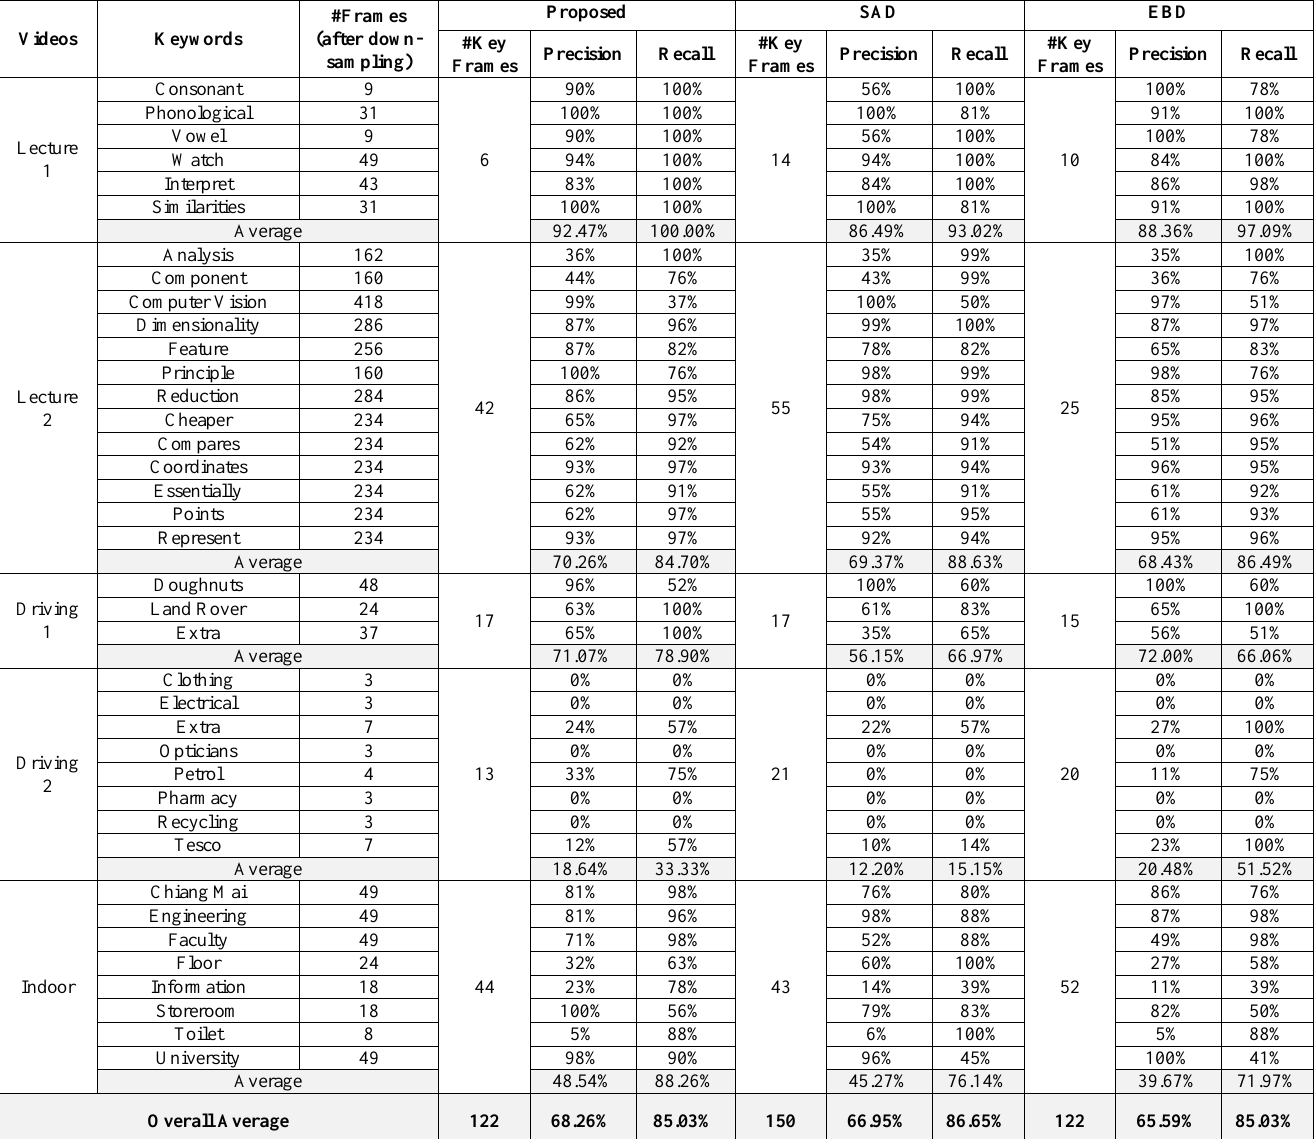
P RECISION AND RECALL OF EACH QUERY